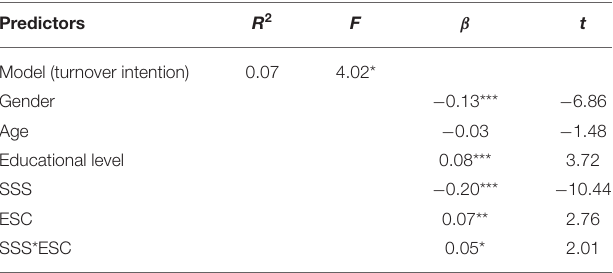
TABLE 3 | Testing the moderated mediation effect of subjective socioeconomic status on turnover intention. Predictors